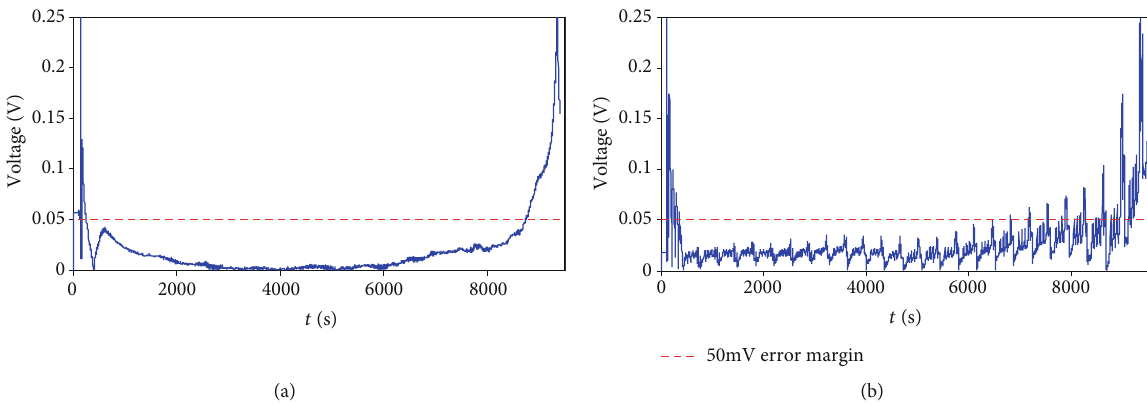
Figure 4: (a) Terminal voltage error in experiment 1. (b) Terminal voltage error in experiment 2.